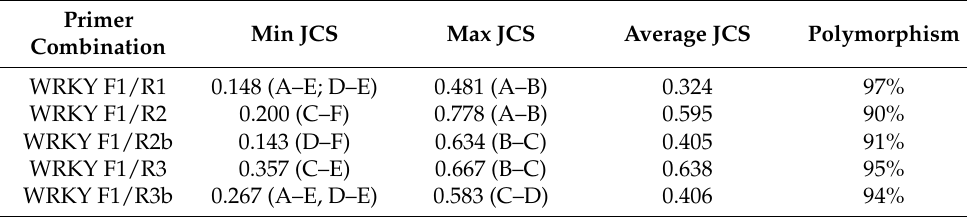
Table 3. Characteristics of Jaccard coefficients of similarity values and polymorphism of individual primer pairs used in the